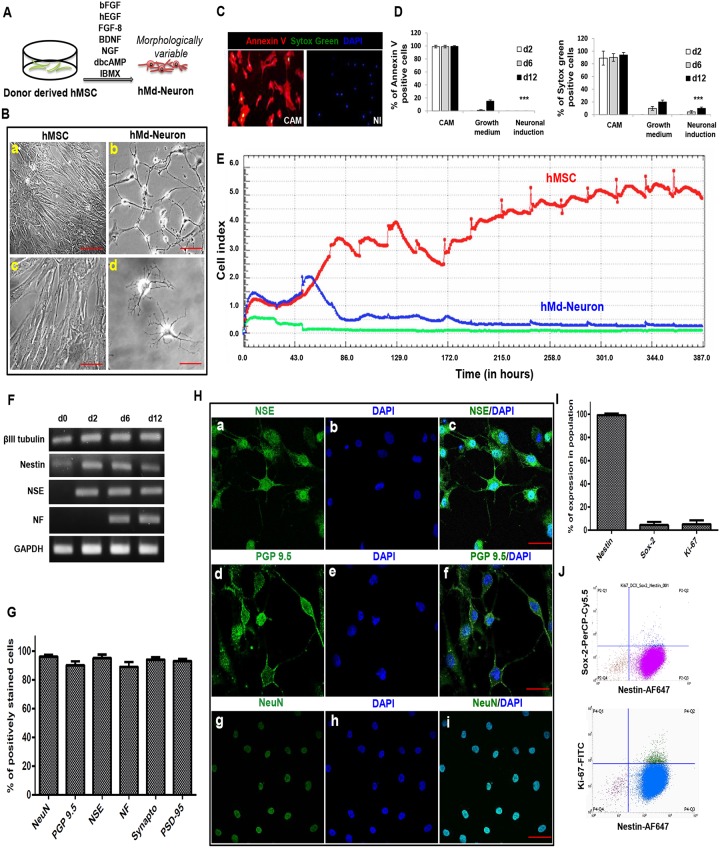
Bone marrow hMSCs from healthy donors differentiated into hMd-Neurons with phenotypical characteristics (A) Schematic representation of neuronal induction on bone marrow derived hMSCs from healthy donors. (B) Bright field images represents almost %90 of neuronal induced human bone marrow donor derived hMSCs give rise morphologically variable neuron like cells on culture at day 12 (b, d) whilst uninduced hMSCs maintains proliferation (a, d). Morphology of hMd-Neurons from human samples varies in culture as seen with neurite extension patterns (b, d). (S2 Fig). (C) Representative florescent images of Annexin V/Sytox green stainings showing cell viability of neuronal induced hMSCs with positive control stainings of dead cells on camptothecin (CAM) treated uninduced hMSCs. (D) Positively stained cells from Annexin V and sytox green stainings of 3 different donors were counted and the percentages of dead cells were determined. Plots indicate dead cell percentages from d2 to d12 in CAM treated, untreated (in growth medium), and neuronal induced hMSCs. (E) Graph showing time dependent cell proliferation profile of uninduced and neuronal induced hMSC during 12 days in culture by X-Celligence (Roche) real time cell analysis (RT-CA) system (F) RT-PCR demonstrating presence of βIII tubulin, Nestin, NSE, NF transcripts during neuronal differentiation (d2-d12) respectively versus an absence in uninduced hMSCs (d0). (G) Plots indicating neuronal marker expression percentages ≥%89 (Images from 3 different donors were counted to determine the neuronal marker percentages). Positively immunostained cells counted from 10 different areas of stainings and averages were calculated. (H) Representative confocal images showing neuronal protein expressions; NSE, PGP 9.5 and NeuN respectively (a, d, g) with DAPI nuclear stainings (b, e, h) of hMd-Neurons at d12 after neuronal induction. Fluorescent images of neuronal protein expressions merged with DAPI staining (c, f, i). (I) Plots represents flow cytometry results indicating 99.24% of hMd-Neurons are Nestin positive and negative for Ki-67 proliferation marker and Sox-2 expressions at day6of NI. (J) Flow cytometry analysis indicates loss of Ki-67 proliferation marker and Sox-2 expressions in Nestin positive cells. Scale bars represent 100 μm. Data are represented as mean ± S.E.M. Significance of ANOVA test *** p <0.0001.